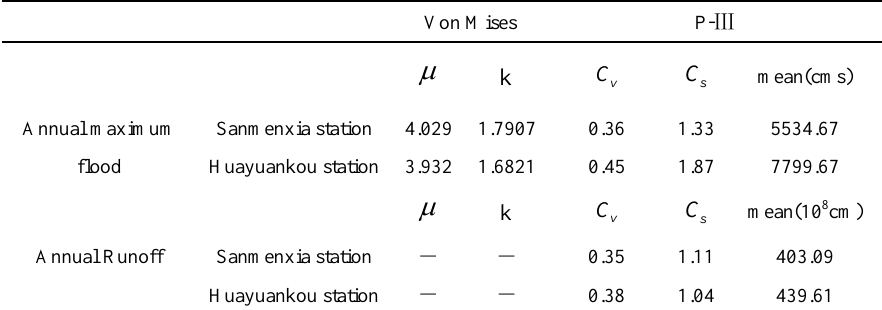
Table2. Parameters of von Mises and P- Ⅲ distribution of Sanmenxia and Huayuankou station.